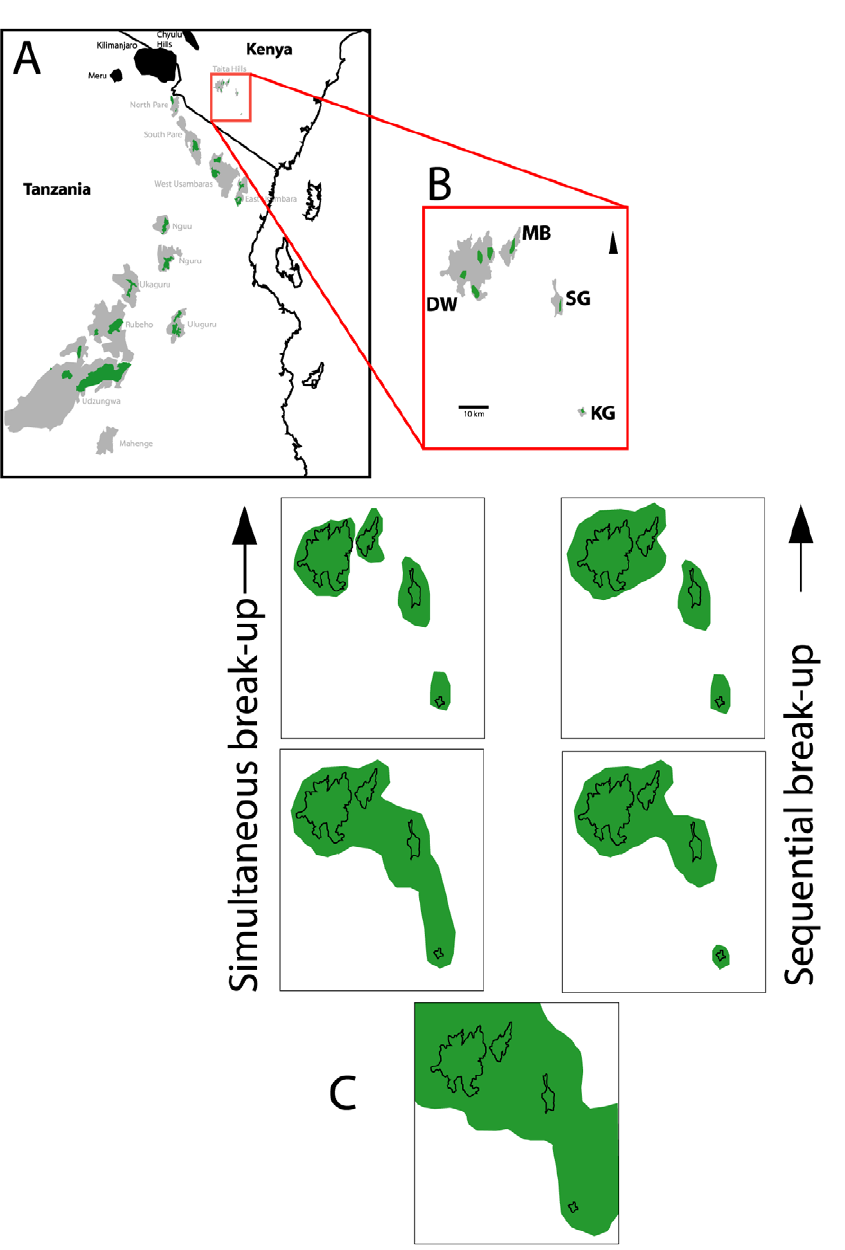
Figure 1. Two potential vicariance scenarios for break-up of forests. A and B show pathways of different break-up scenarios in the northernmost component of the C) Eastern Arc Mountains (shown in grey with volcanic mountains in black): Dawida (DW), Mbololo (MB), Sagalla (SG) and Kasigau (KG) make up the Taita Hills (D). A) shows forest (in green) shrinking around the mountains with eventual fragmentation in lowland areas occurring simultaneously.(B) shows a scenario whereby forest (in green) on the most distant mountain (Kasigau – see D) is the first to separate and the other mountains follow successively.